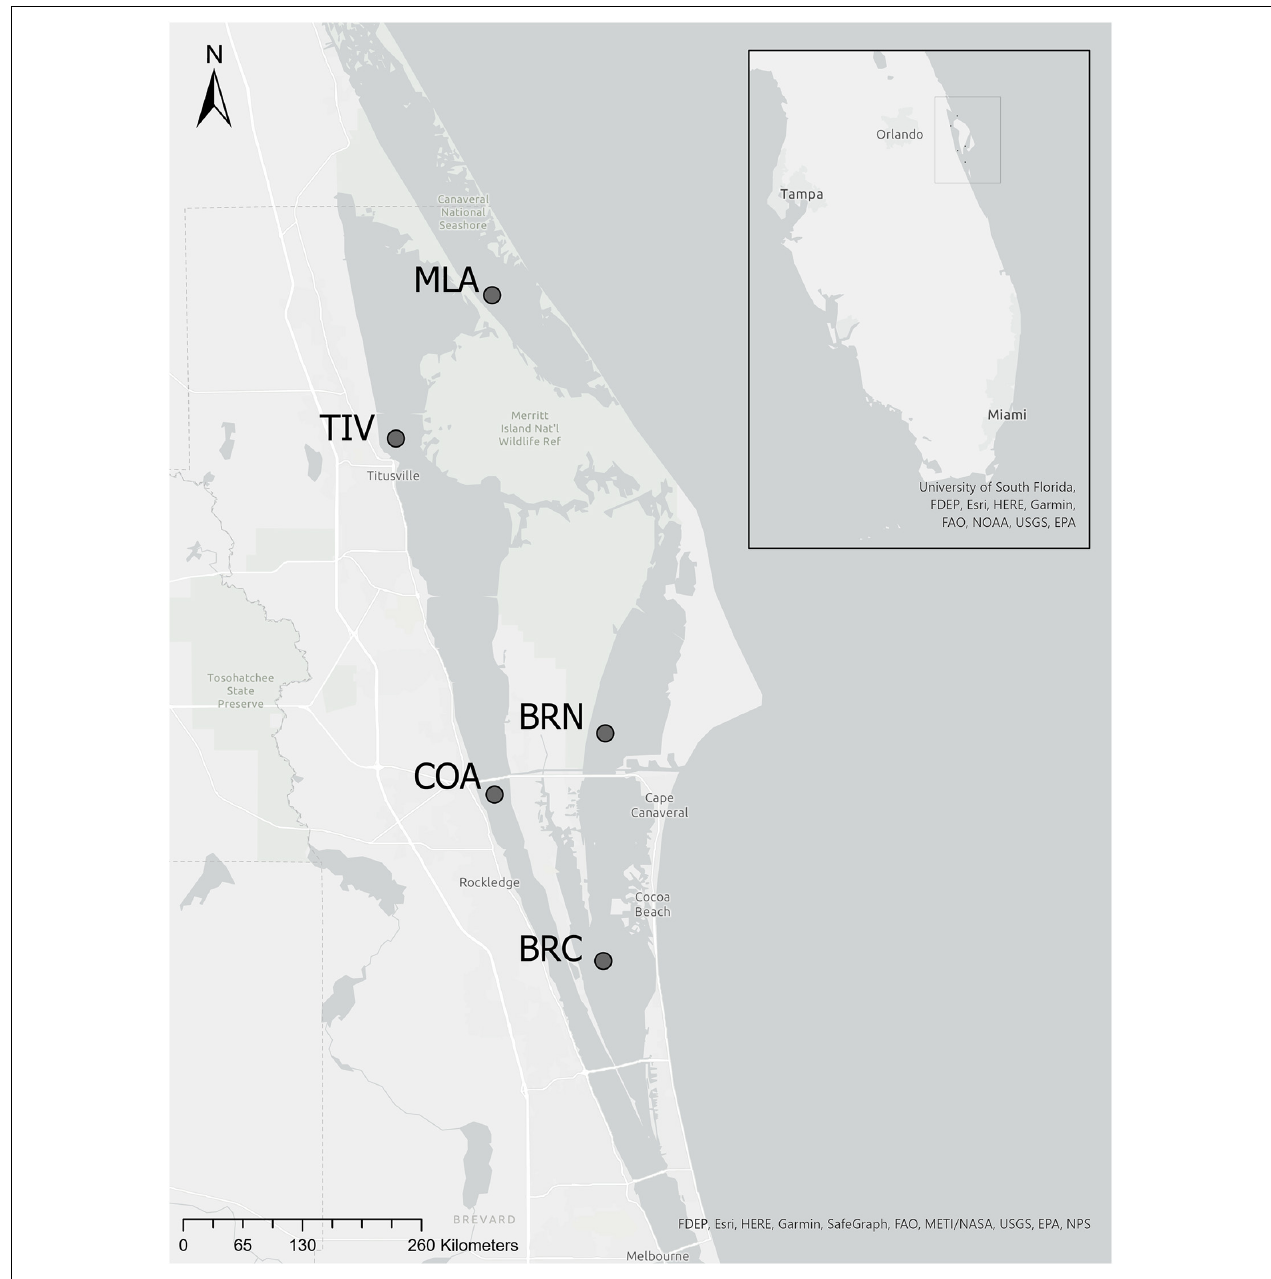
FIGURE 1 | Five mesozooplankton sampling sites in the northern Indian River Lagoon system, east central Florida, United States.